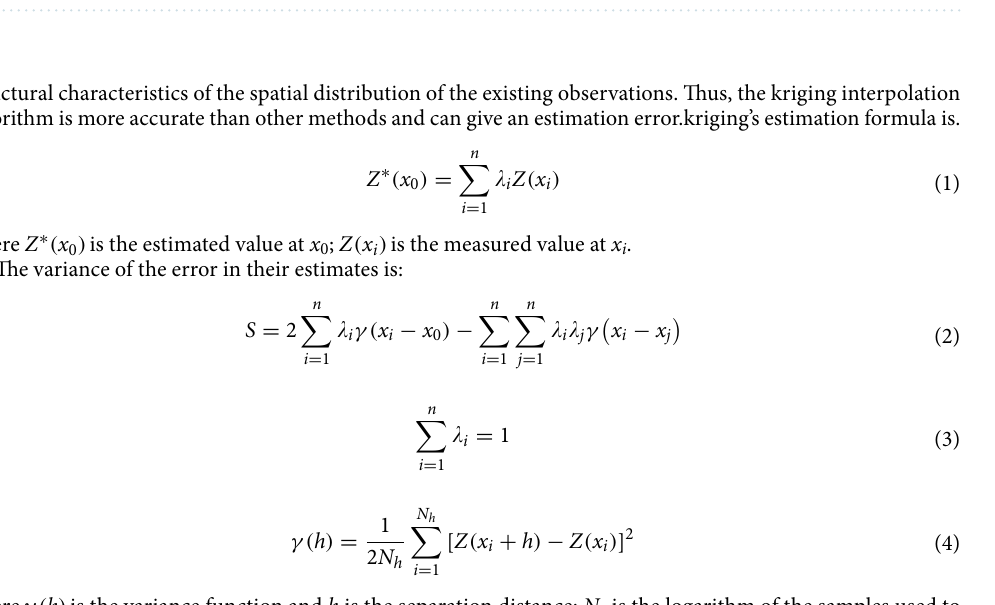
Table 5. Effective data volume at different elevations in winter.